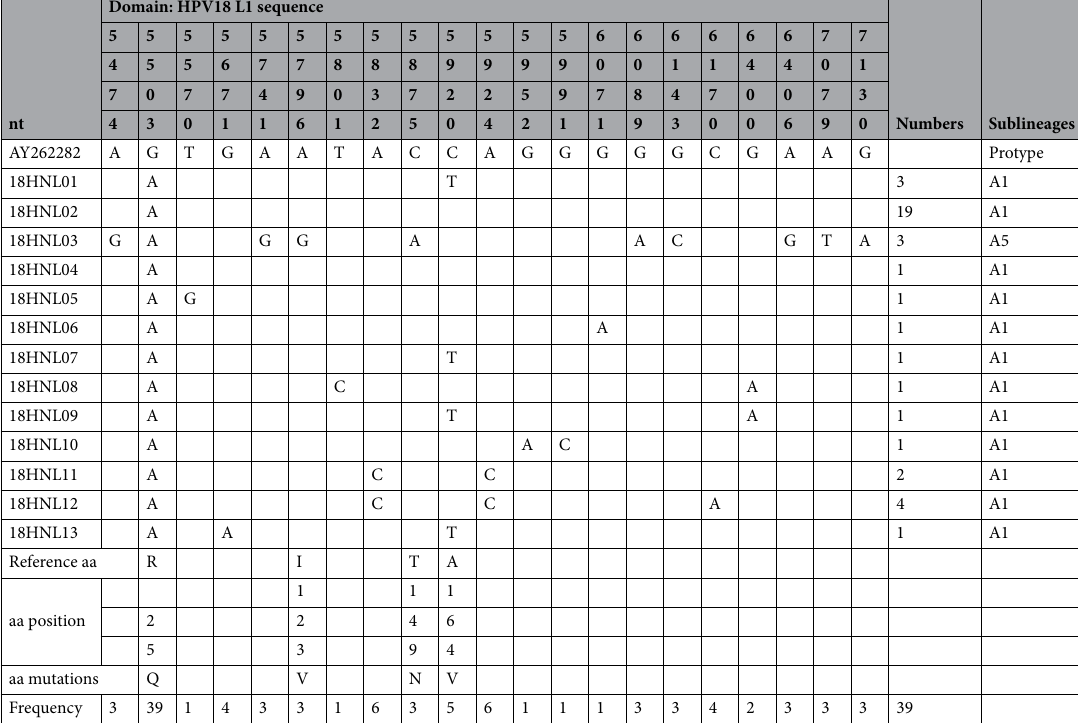
Table 2. Nucleotide sequence mutations of HPV18 L1 gene. Positions without variants are marked with blank, whereas positions with variants are indicated by a